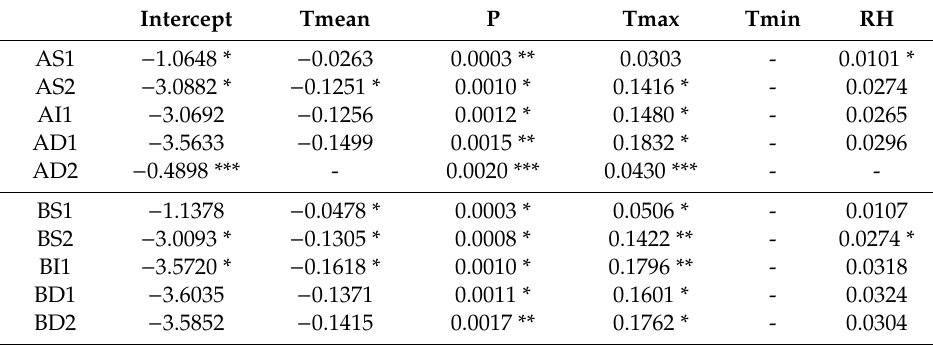
Table 4. Stepwise regression of radial growth and climate factors in di ff erent groups. Intercept